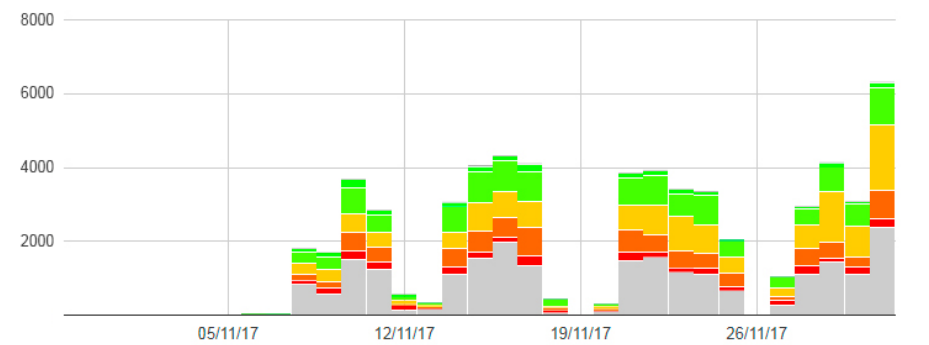
Figure 2. Volunteers performance over time. Each colour represents a different classification, where green represents positive tweets, red represents negative tweets and grey colours represents neutral and out-of-context tweets. The horizontal axis is measured with GMT+01:00. Each tweet was rated individually by different